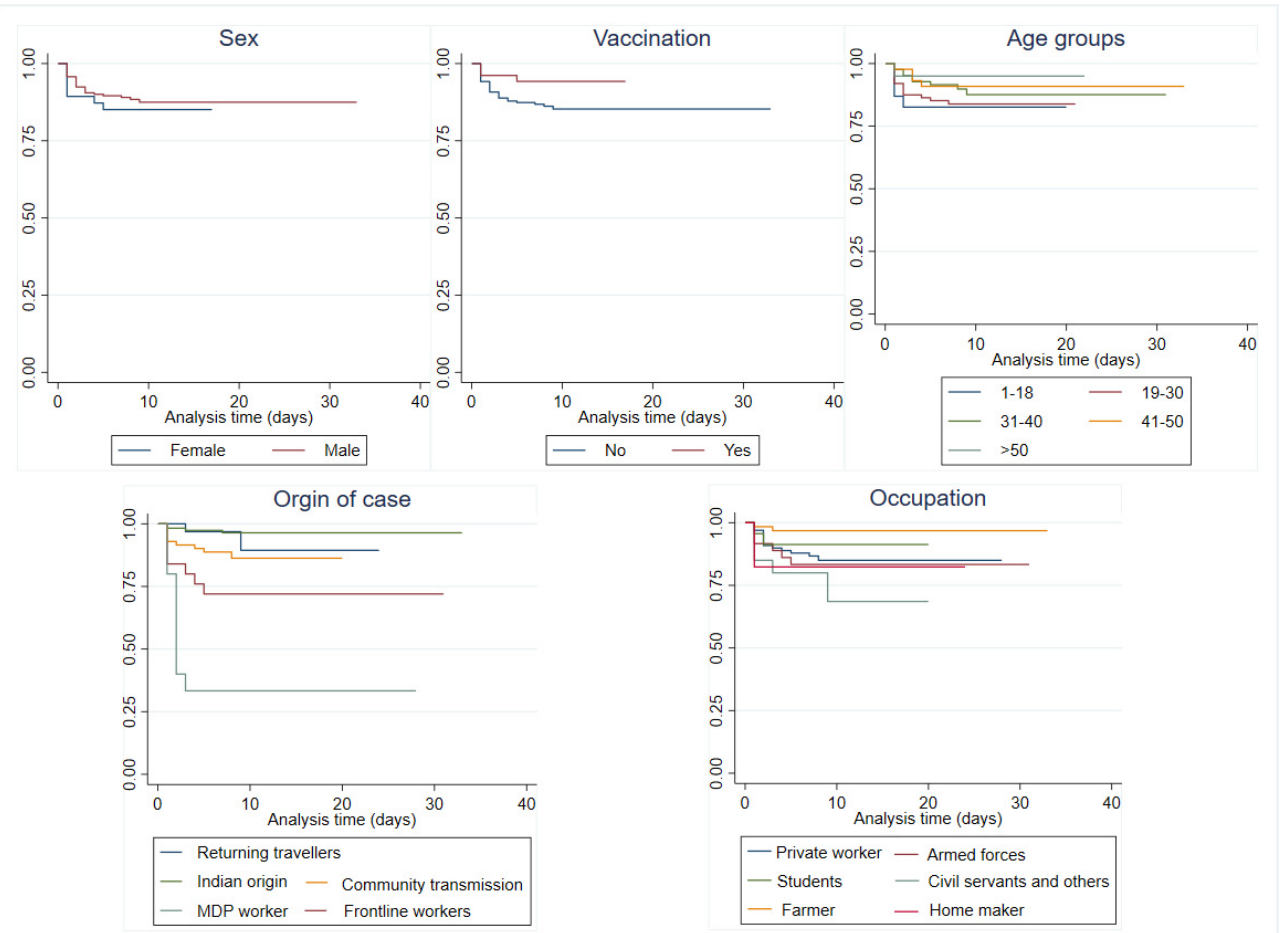
Figure 4. Kaplan-Meier survival estimates for the probability of developing symptomatic COVID-19 based on different covariates in the Phuentsholing municipality, Bhutan. These results were further supplemented by the significant differences in the logrank tests for origin of cases ( p < 0.001) and presence of risk factors ( p < 0.001) for absolute lymphocyte count( p = 0.022) (Figure 5).